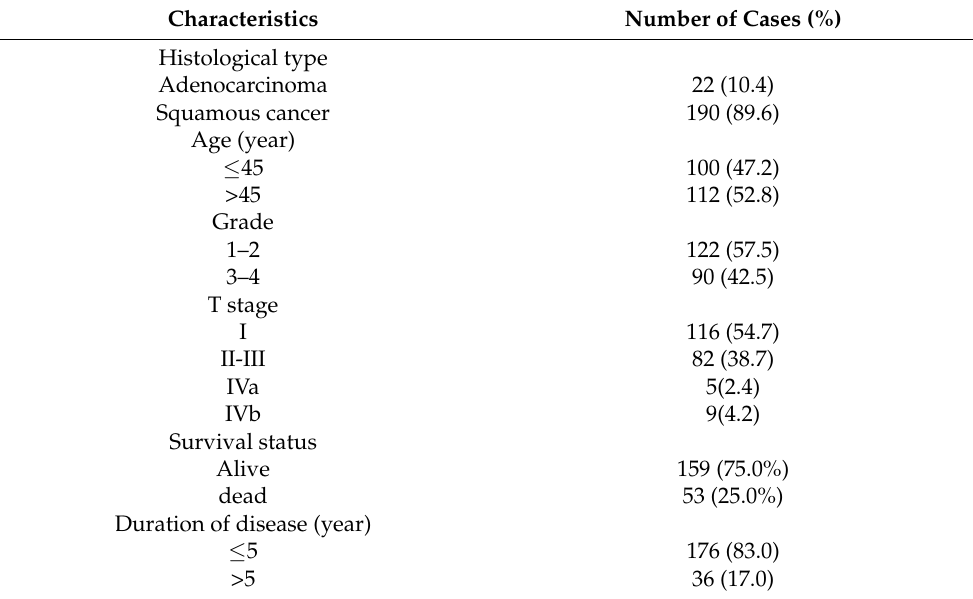
Table 6. The characteristic of 212 clinical